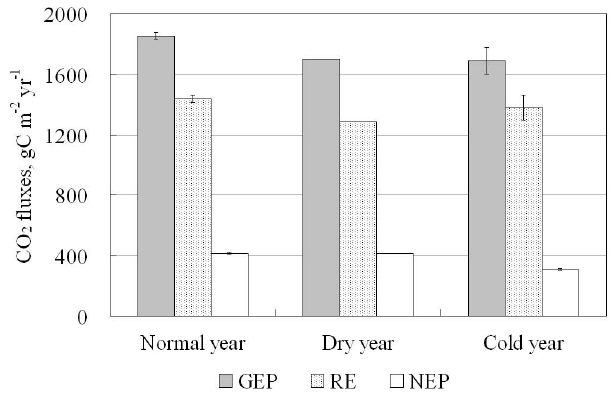
Fig. 8. Averaged annual CO 2 fluxes (gCm − 2 ) of normal years (2004, 2006 and 2007), dry year (2003) and cold years (2005 and 2008) at QYZ